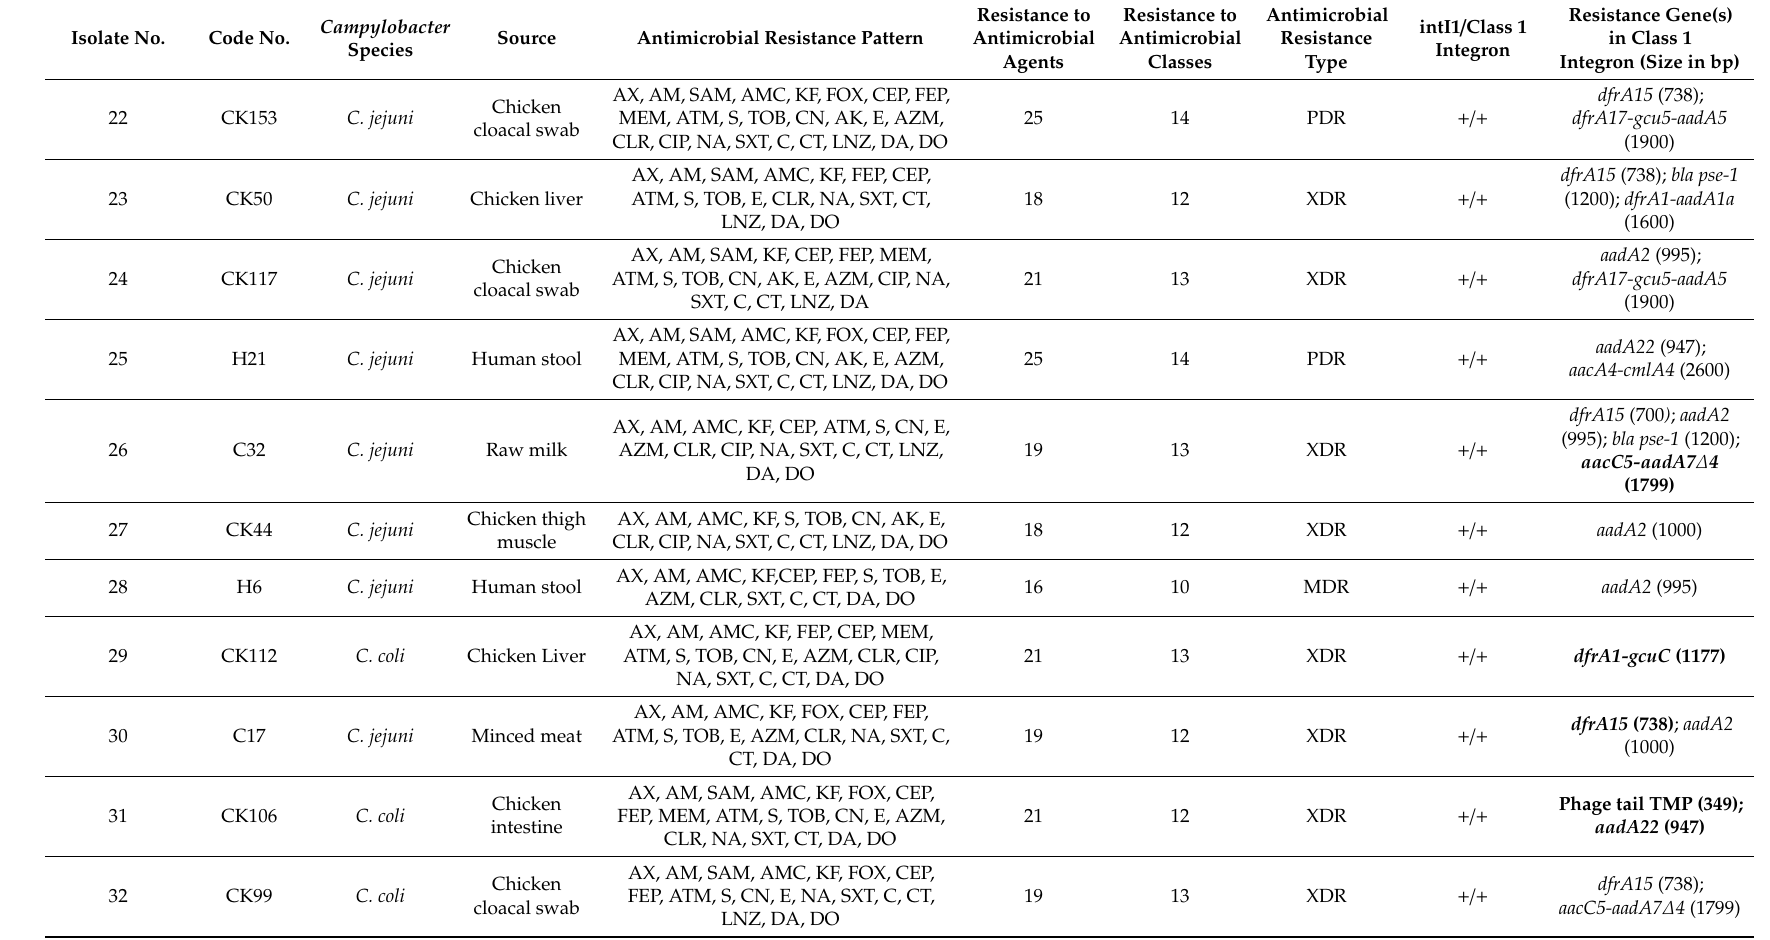
Isolate No. Code No.